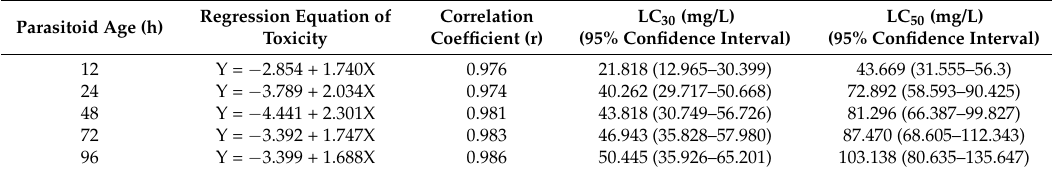
Table 3. Toxicity of imidacloprid to Encarsia formosa